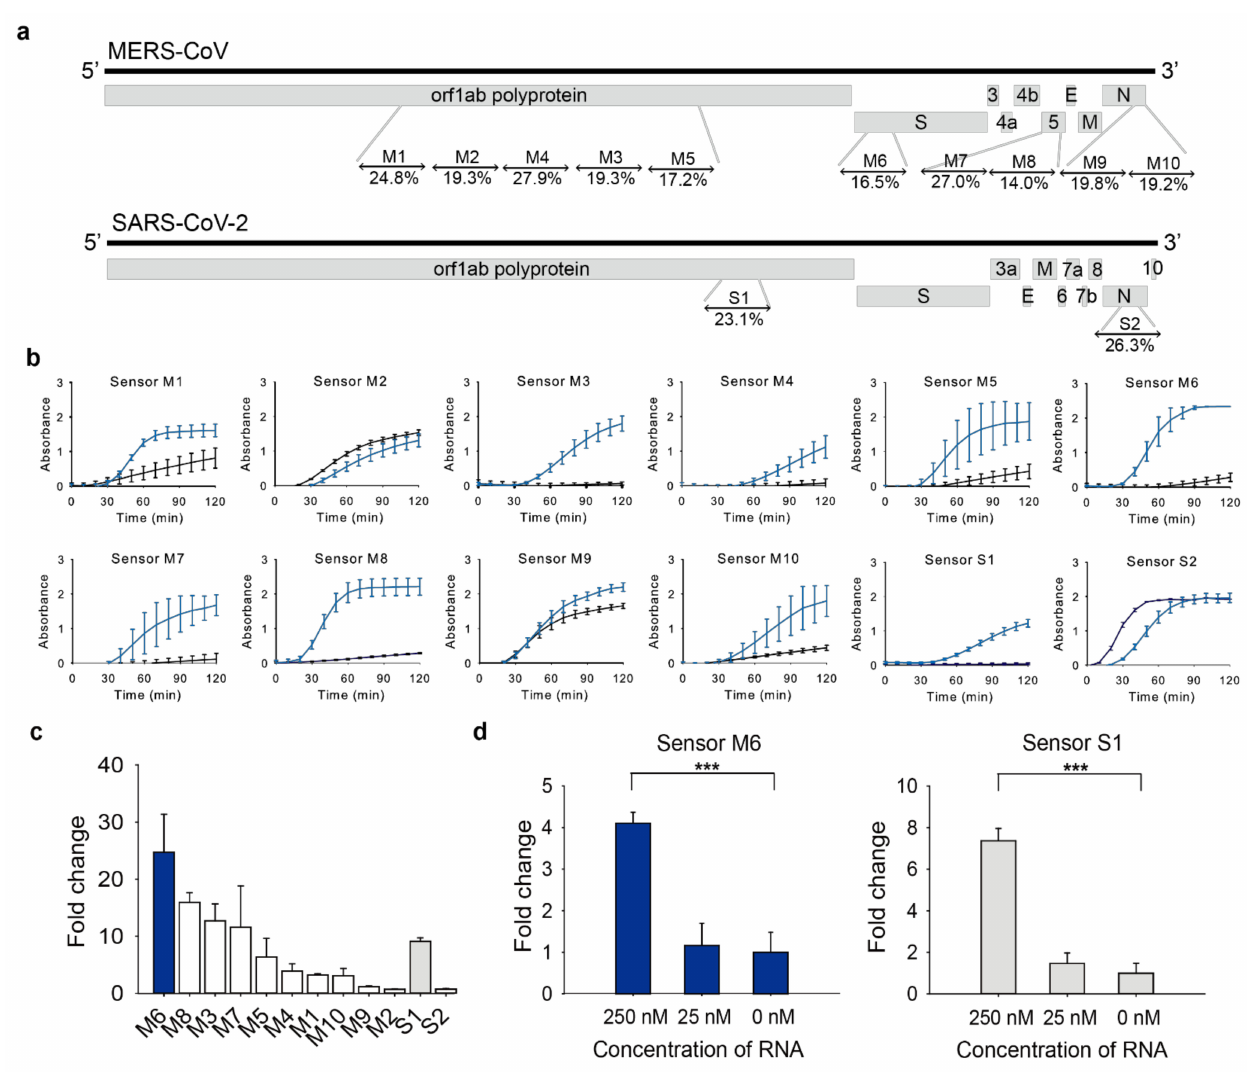
Figure 2. Toehold switch sensor screening. ( a ) Target regions and normalized ensemble defect (%) of each toehold switch sensor were indicated. ( b ) Absorbance changes at 570 nm of toehold reaction with or without trigger RNA in a cell-free system on a paper-disc. Blue line: toehold reaction with trigger RNA (on-state), Black line: toehold reaction without trigger RNA (off-state). ( c ) Fold changes of toehold switch sensors in Figure 2b at 60 min. ( d ) Sensitivity of sensor M6 and S1 with different concentrations of trigger RNA. Fold change was calculated as the toehold reaction with trigger RNA divided by that without trigger at 60 min. Two-tailed student’s test; *** p < 0.001; Error bars represent ± s.d., n =